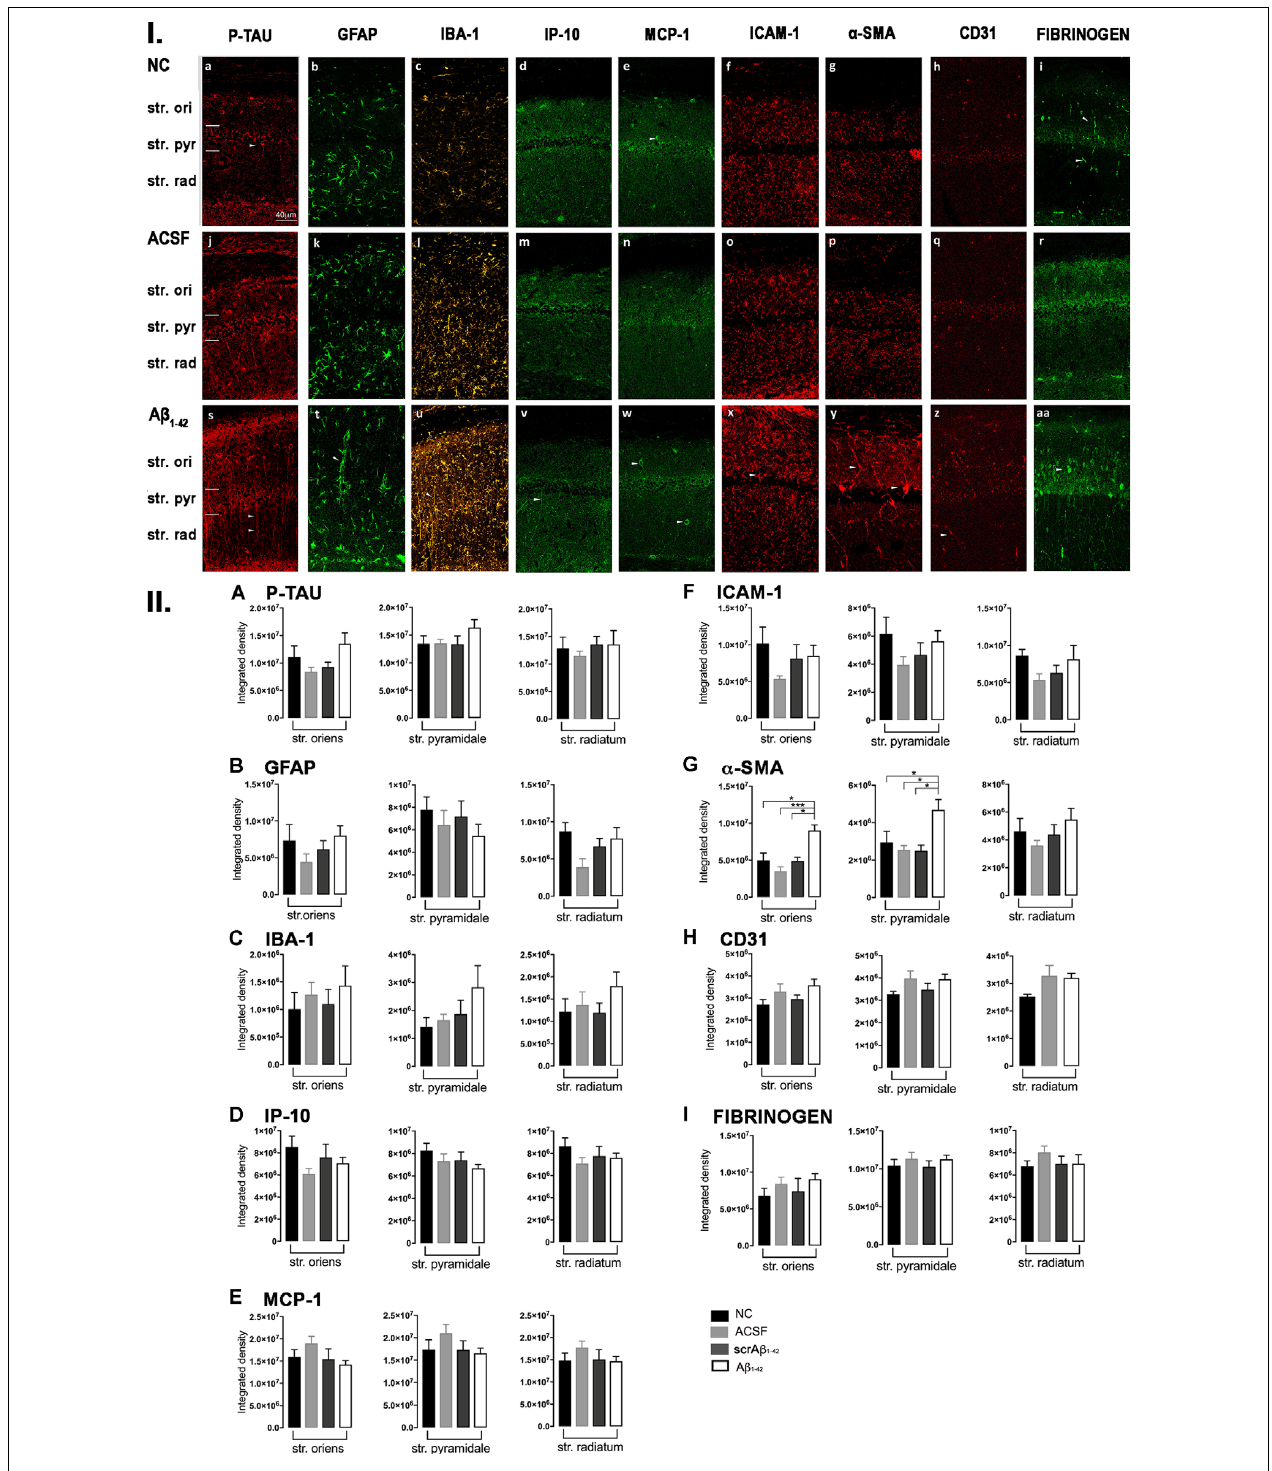
FIGURE 7 | Panel I: Representative images showing immunolabeling of p-tau, GFAP, Iba-1, IP-10, MCP-1, ICAM-1, a-SMA, CD31 and fibrinogen at a location adjacent to the injection site, 30 days post- injection in NC (a–i) , ACSF-injected (j–r) and A β 1–42 -injected (s–aa) mice. Panel II: Graphs showing quantification at a location adjacent to the injection site in the CA1 hippocampal region of p-tau, GFAP, Iba-1, IP-10, MCP-1, ICAM-1, α -SMA, CD31 and fibrinogen immunolabeling density, 30 days post injection in NC, ACSF-, scrAb1–42- and Ab1–42-injected mice. Data expressed as mean SEM (Kruskall–Wallis test; * p < 0.05; *** p < 0.001, n =